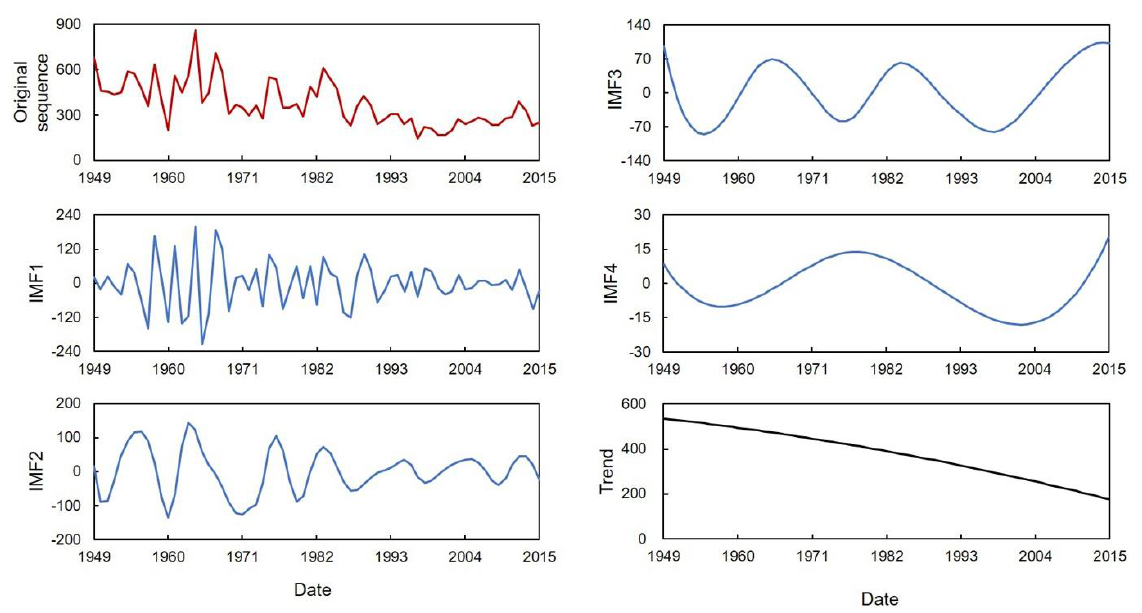
Figure 9. Wavelet spectra of LHS.